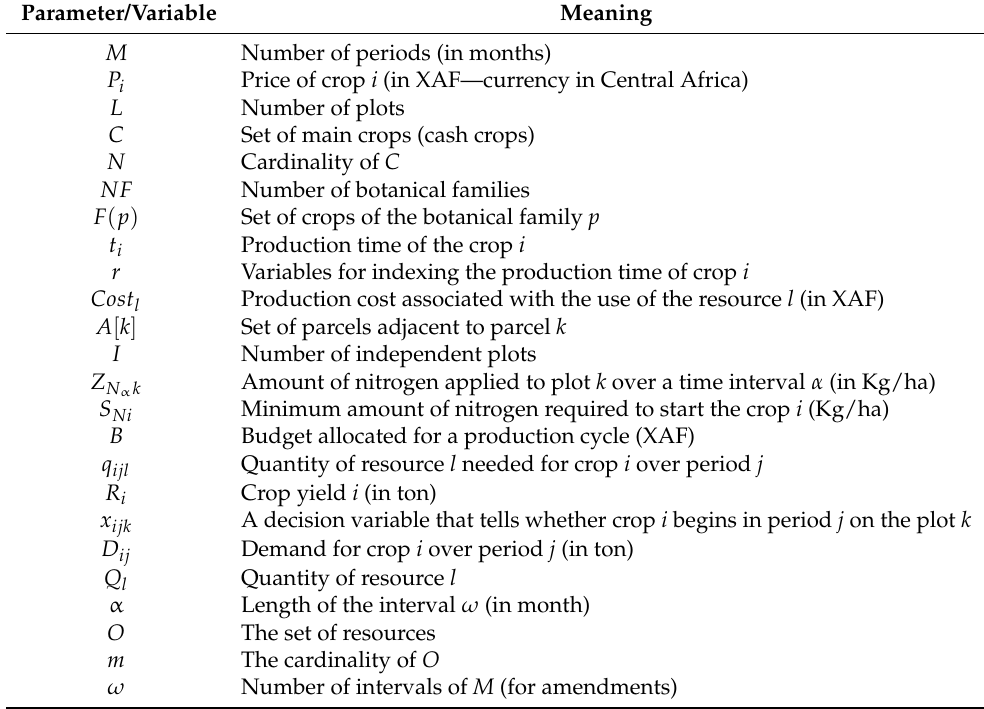
Table 3. List of parameters and